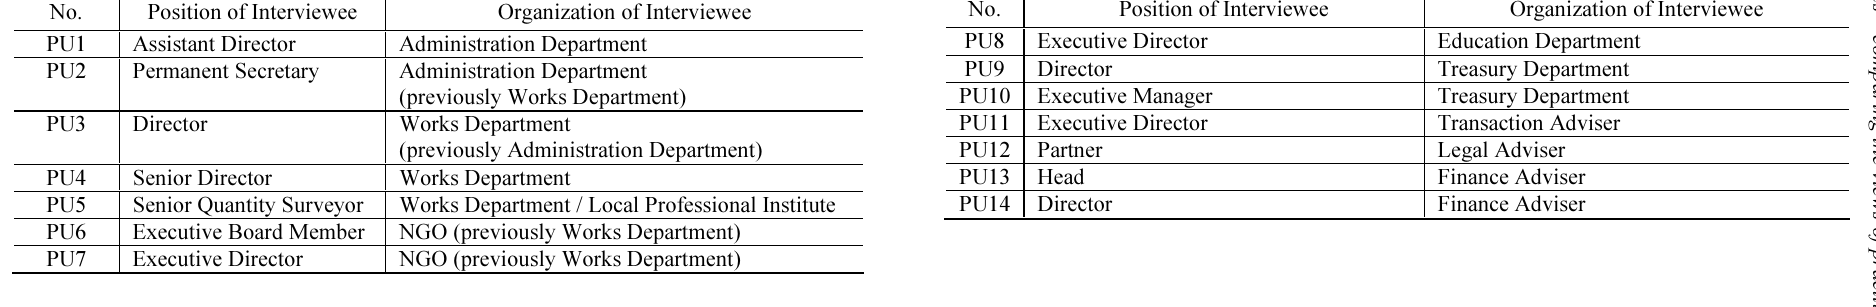
Table 3. List of Interviewees from the Public sector in Hong Kong No.